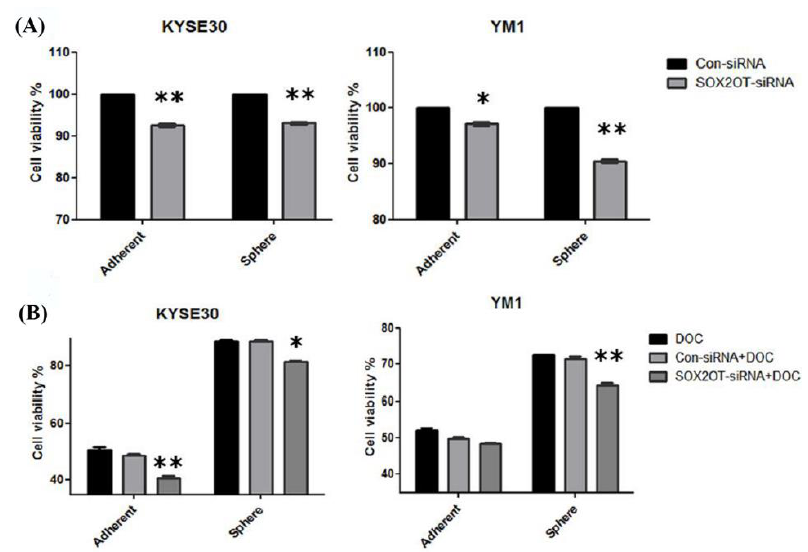
Figure 7. SOX2OT knockdown decreases the viability alone or in combination with docetaxel. The cytotoxicity of SOX2OT knockdown has been shown for both cell line adherents and spheres ( A ). The chemotoxicity of docetaxel (IC50) alone or in combination with SOX2OT-siRNA has been shown for both cell lines adherent and sphere cells ( B ). Doc: docetaxel. The two-way ANOVA test with Bonferroni comparison has been calculated by graph pad. * p -value < 0.01 and ** p -value < 0.001. Each Bar represents mean ± SE.